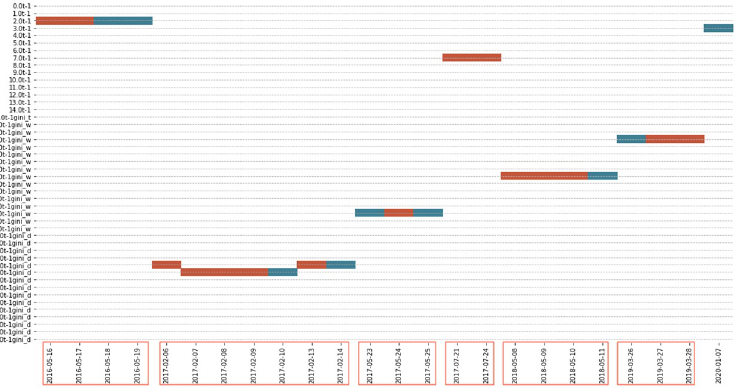
Fig 13. Different topic score models chosen for prediction in model 1 in public data. The graph shows the result from the best model of the public data—model 1 under the window size of 60 days, with a threshold of 0.4. It indicates the topic score measures chosen by the best subset selection for the predictions and dates in the x-axis representing the last day of the regression period. The red (blue) colour represents where the topic score (benchmark) model outperformed the benchmark (topic score) model.